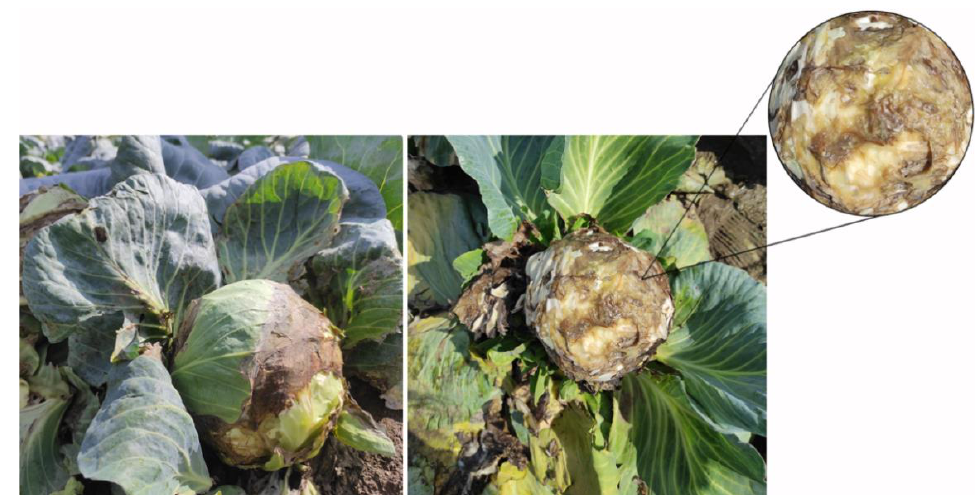
Figure 1. Bacterial soft rot symptoms in visited cabbage fields in Futog (Bačka, Vojvodina ).